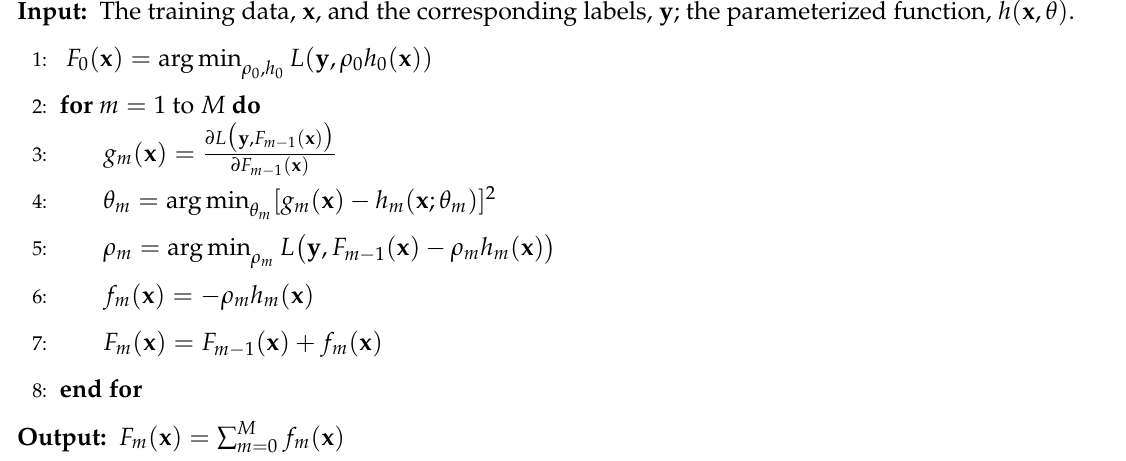
Algorithm 1 The algorithm of gradient boosting